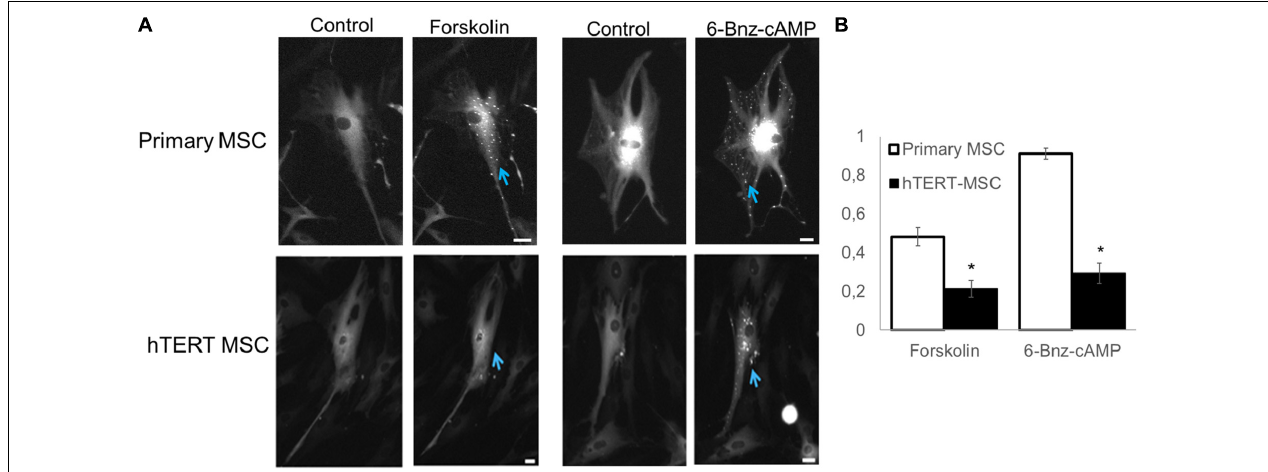
FIGURE 6 | Detection of PKA activation using PKA-Spark sensor . (A) Representative images of sensor response to different stimuli. (B) Comparing the percentage of responsive cells in primary and hTERT-immortalized MSC culture. Results are presented as mean ± SD, n = 4 independent experiments on primary MSCs from two different donors. *Mann–Whitney U test, p <